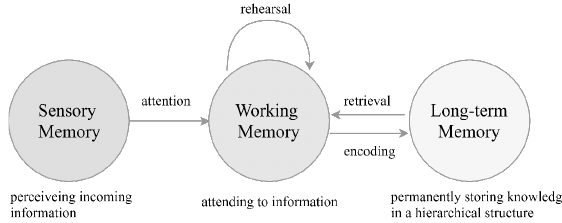
Figure 1. The interaction between memory